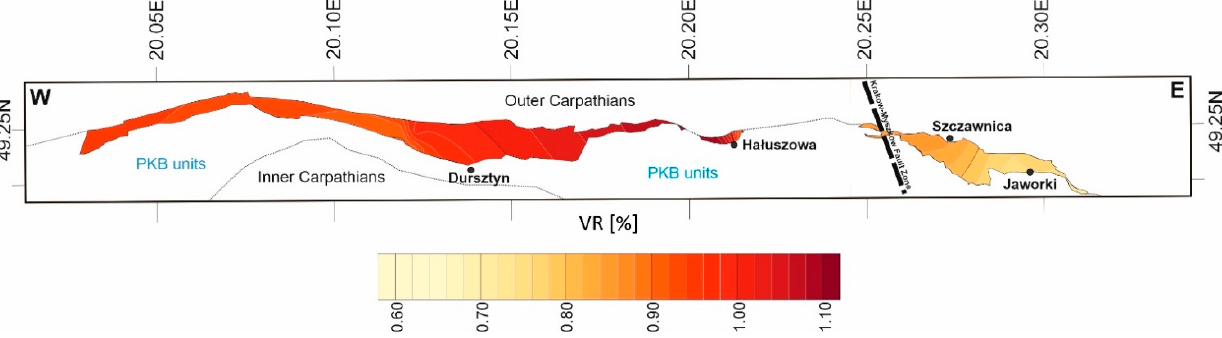
Figure 5. Regional thermal maturity distribution within the Grajcarek Jurassic–Palaeocene succession expressed by VR data .